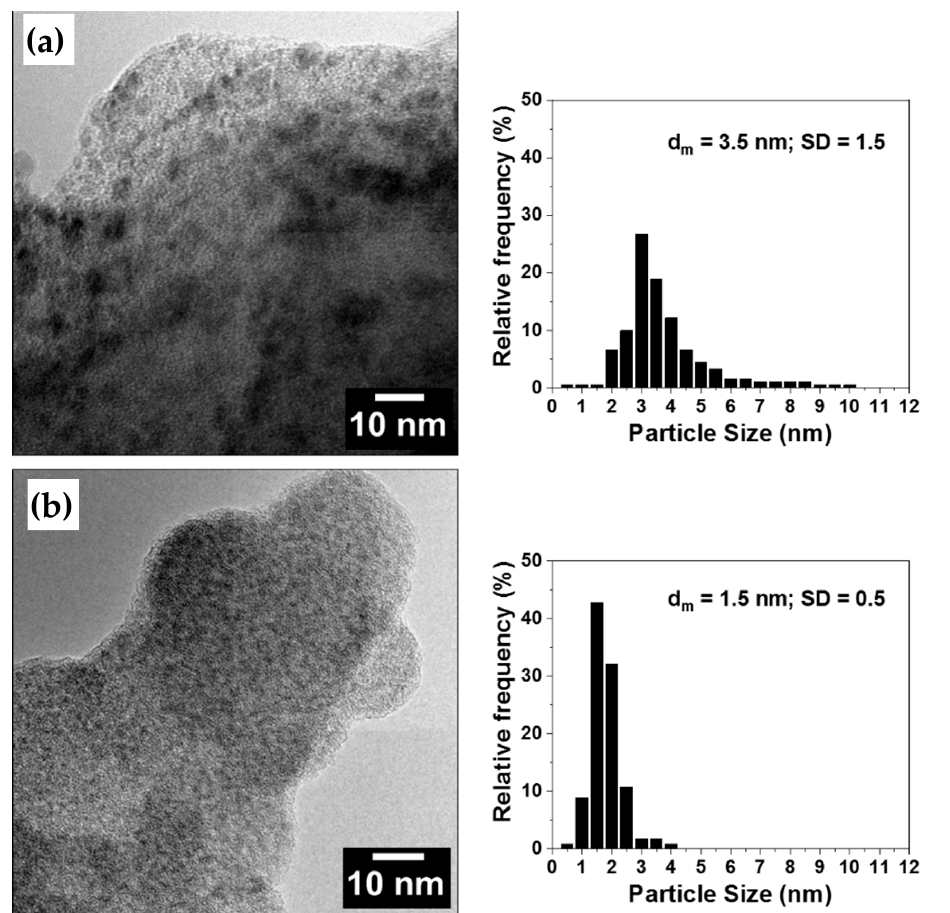
Figure 4. Representative TEM micrograph and histogram of the particle size distribution of Pd/Smopex ® -111 ( a ) and Pd/Smopex ® -234 ( b ).